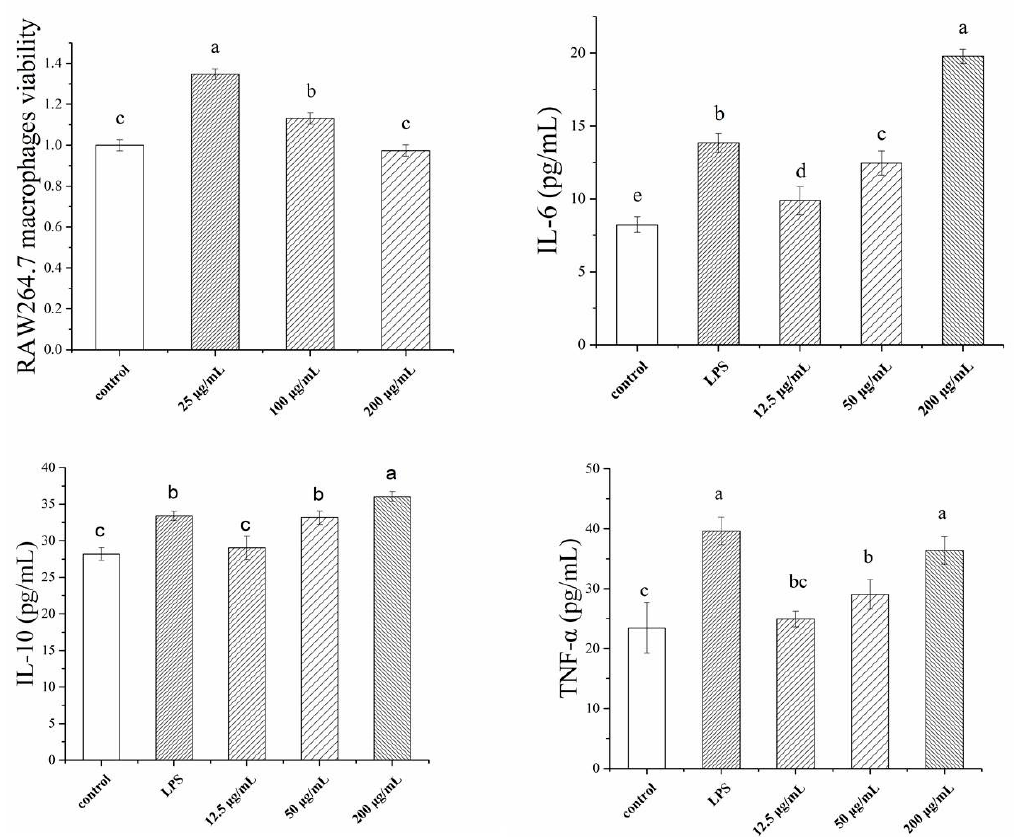
Figure 2. Immunological activity of RAW264.7 macrophages, including macrophages viability, IL-6, IL-10, and TNF- α index, with different concentrations of TSP (a, b, c, d denote significant difference at p < 0.05).